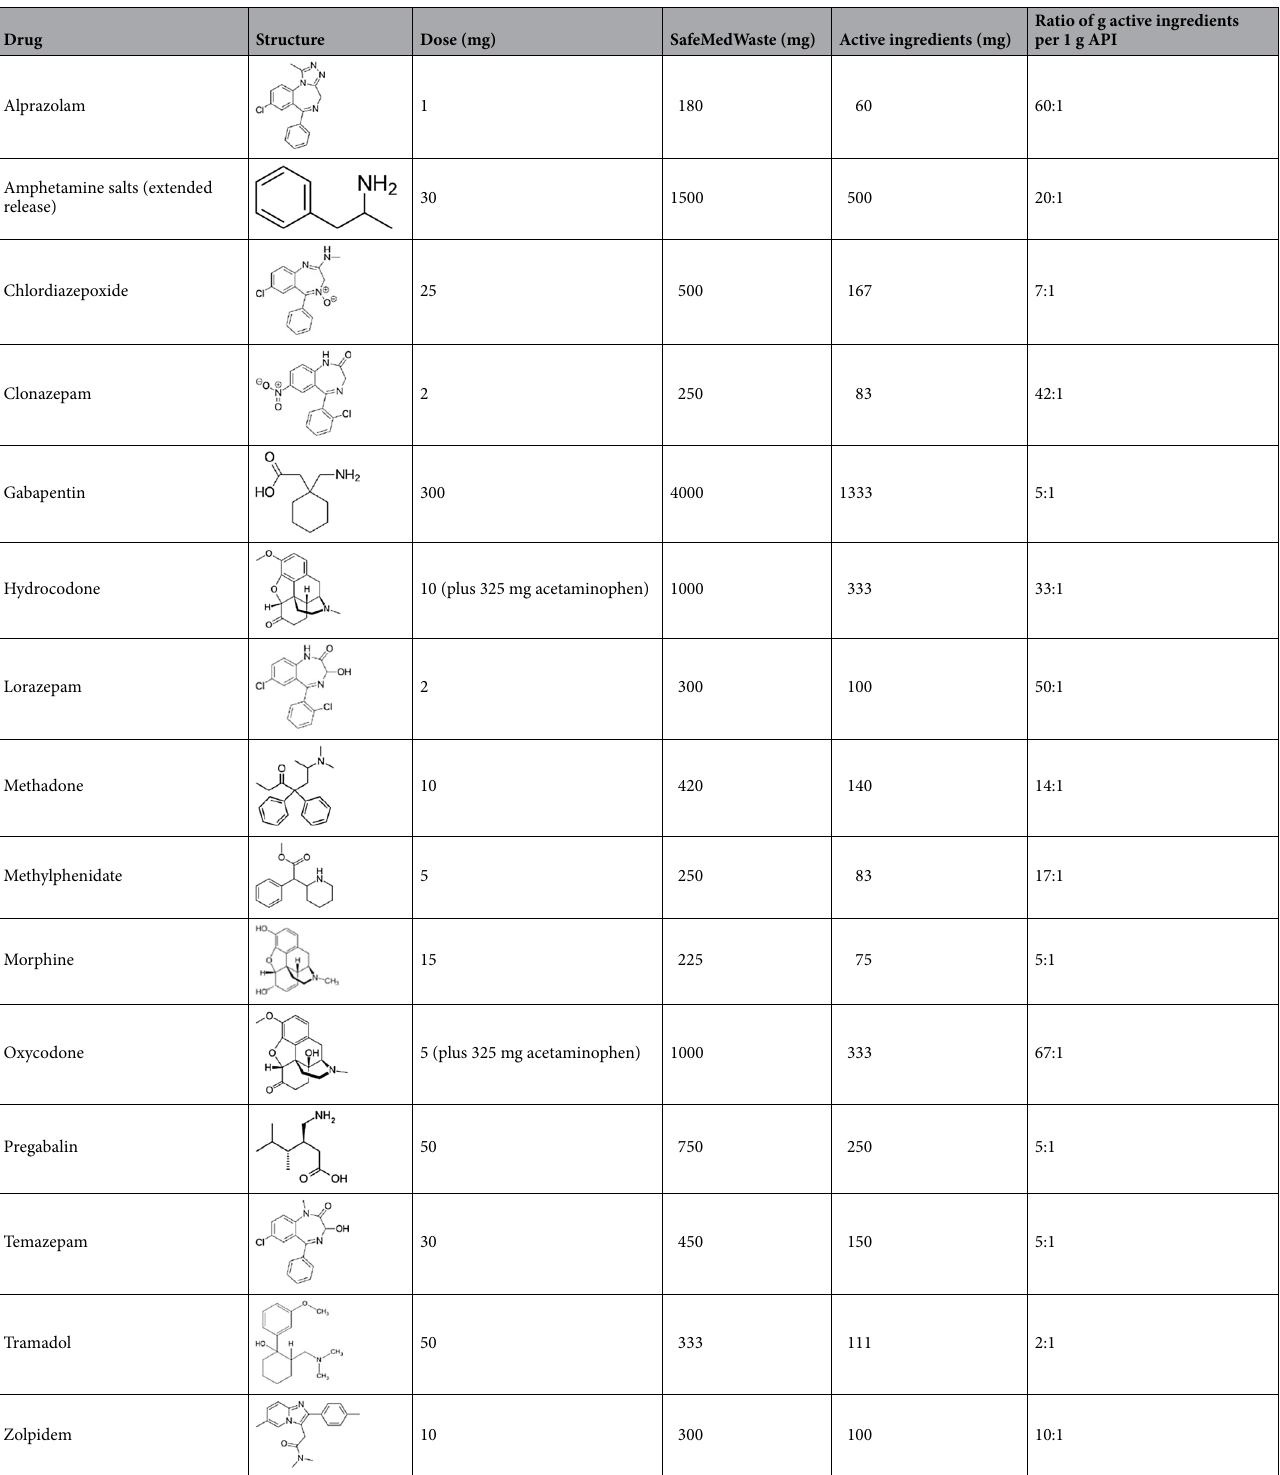
Table 5. Summary of experiments on solid controlled medications. The formulation of SafeMedWaste for solid medications consisted of 1-part active denaturants to 2-parts solidifiers. Tablets/capsules were